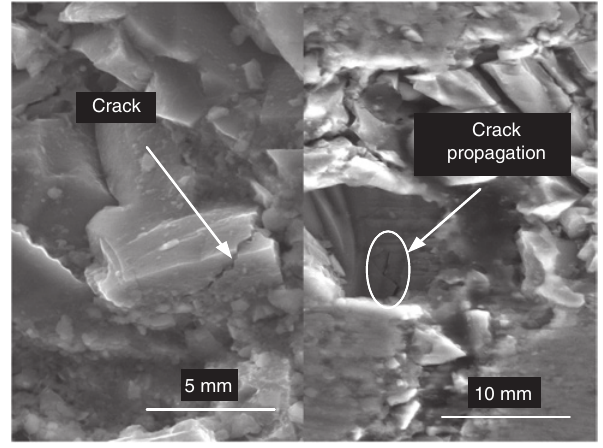
Figure 5: Particle’s cracks and propagation.